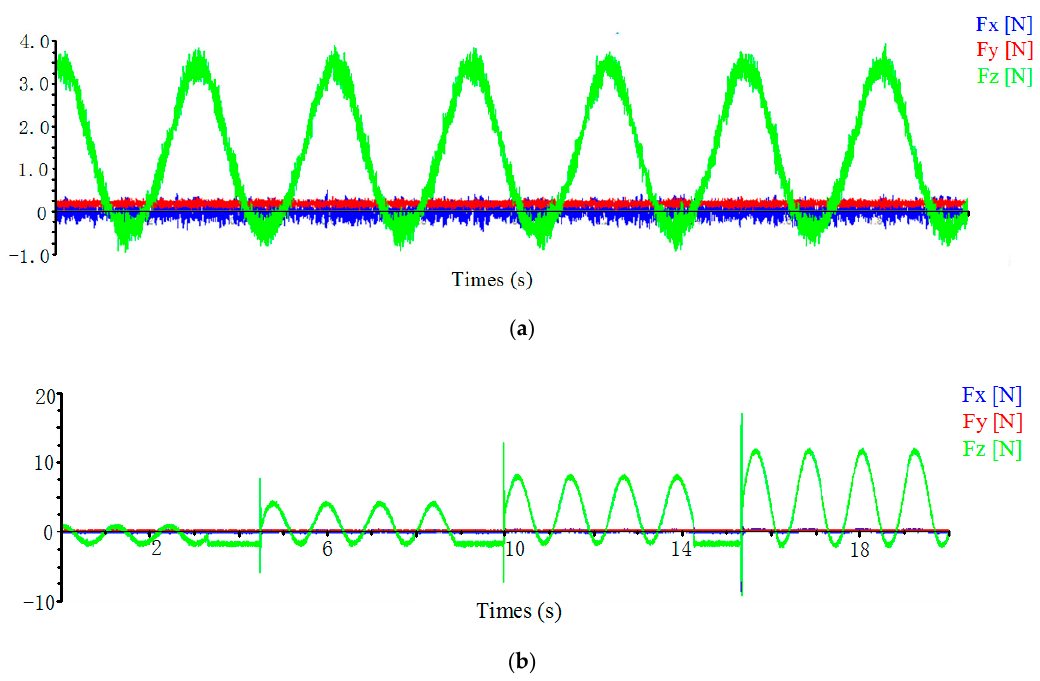
Figure 41. Force curve. ( a ) Effect of z -direction vibration on initial force; ( b ) Force curve during the experiment.